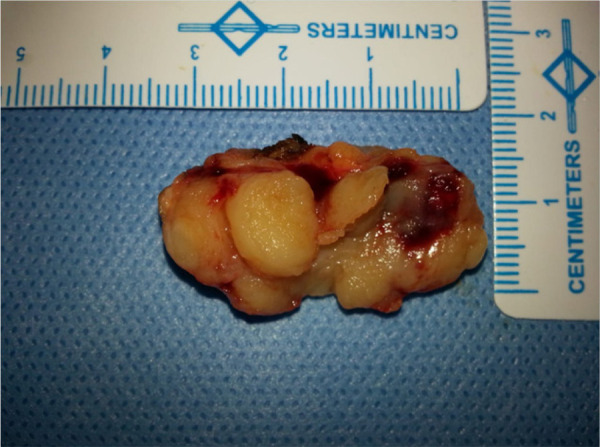
Excision specimen.